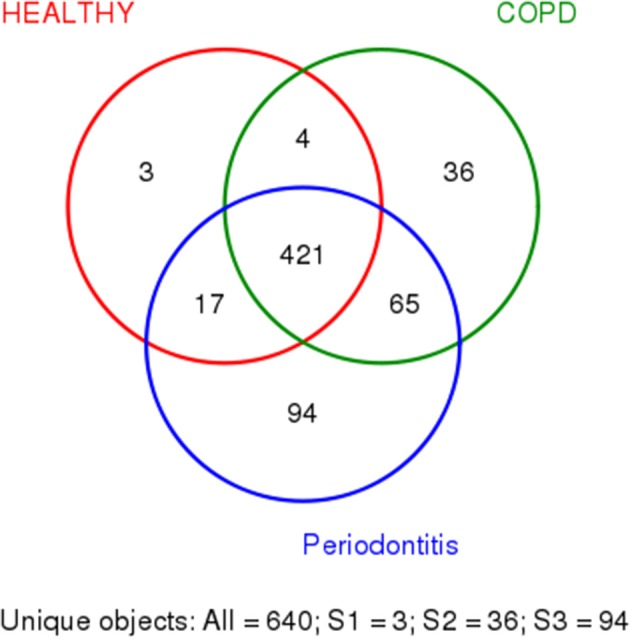
Shared and unique bacteria in patients with periodontitis (P), patients with periodontitis, and COPD (C+P), and healthy controls (H). The different colors represent different groups. The overlap represents shared bacteria. There are 640 unique objects, and 421 appear in all three groups.